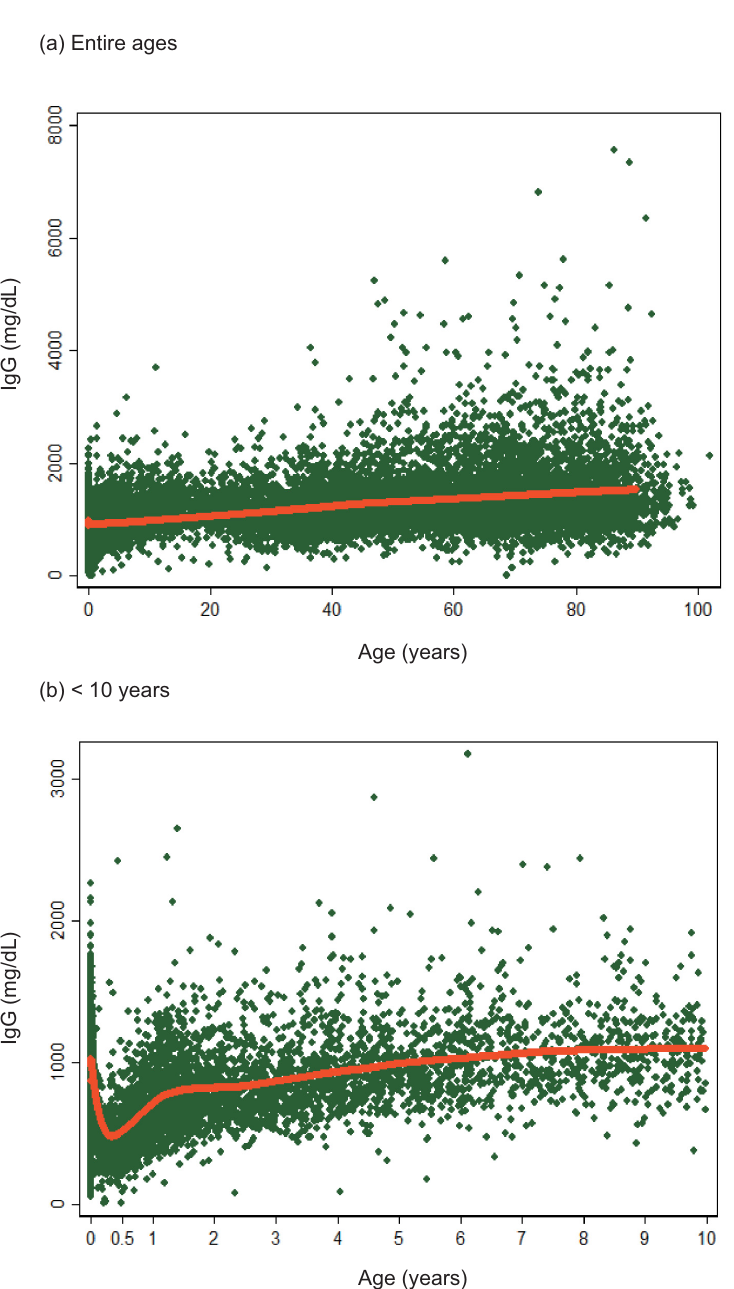
Fig 2. IgG and age. Nonspecific total IgG values, which were tested between January 2010 and December 2021 in Fukuoka Tokushukai Hospital, were plotted against ages of individuals, for all age groups (a), and for individuals < 10 years of age (b). The red lines represent the results for Lowess smoothing with a 14-day bandwidth.